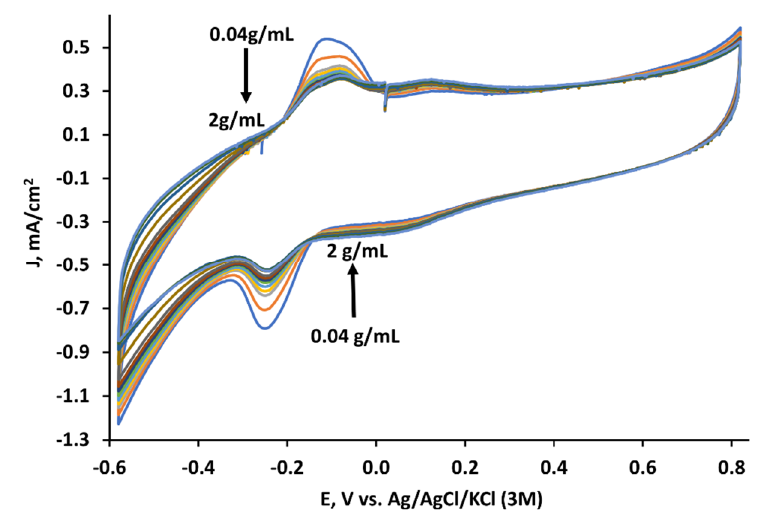
Figure 3. Cyclic voltammograms recorded with the MD-modified anode at different yeast concen- trations in the phosphate–acetate buffer solution. The scan rate was 0.1 V/s. tions in the phosphate–acetate buffer solution. The scan rate was 0.1 V/s.